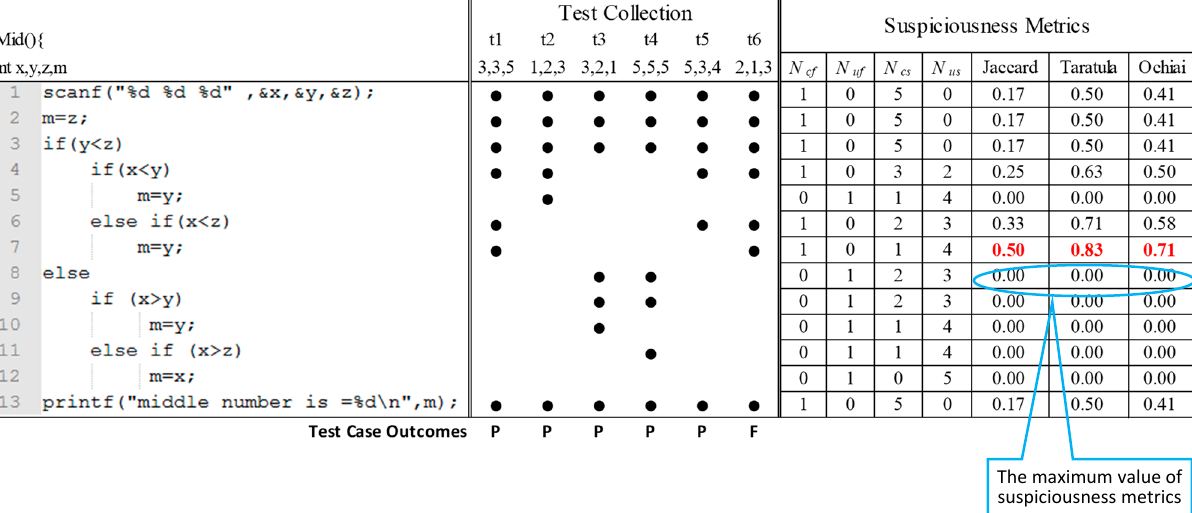
Figure 4. An example program Mid () with suspiciousness metrics.